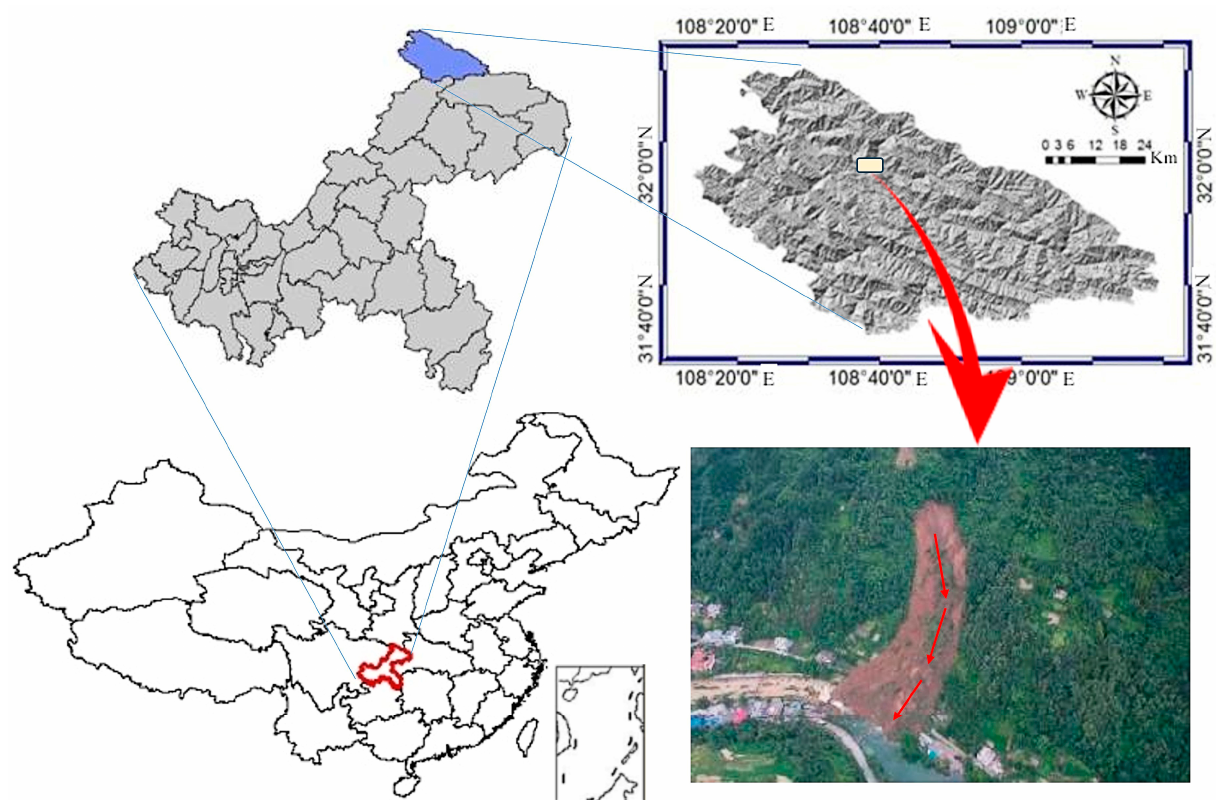
Figure 1. Location of Siwan village’s landslide events.